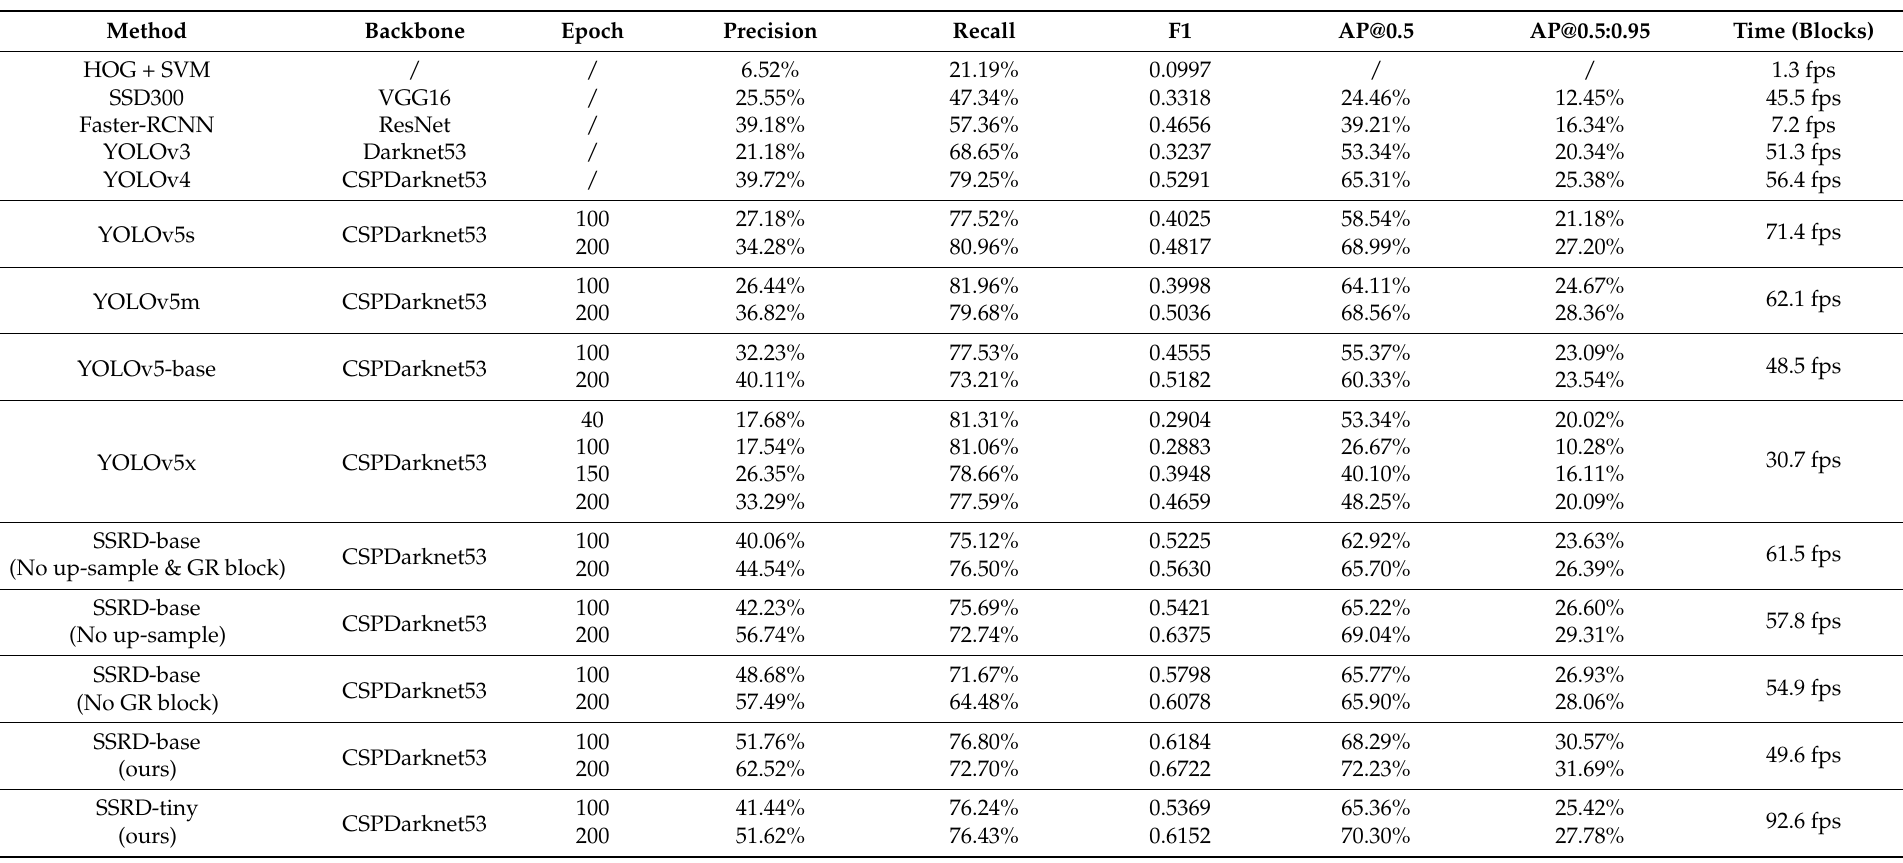
Table 5. Comparison of different network methods on RO-ARS (Rotating bounding